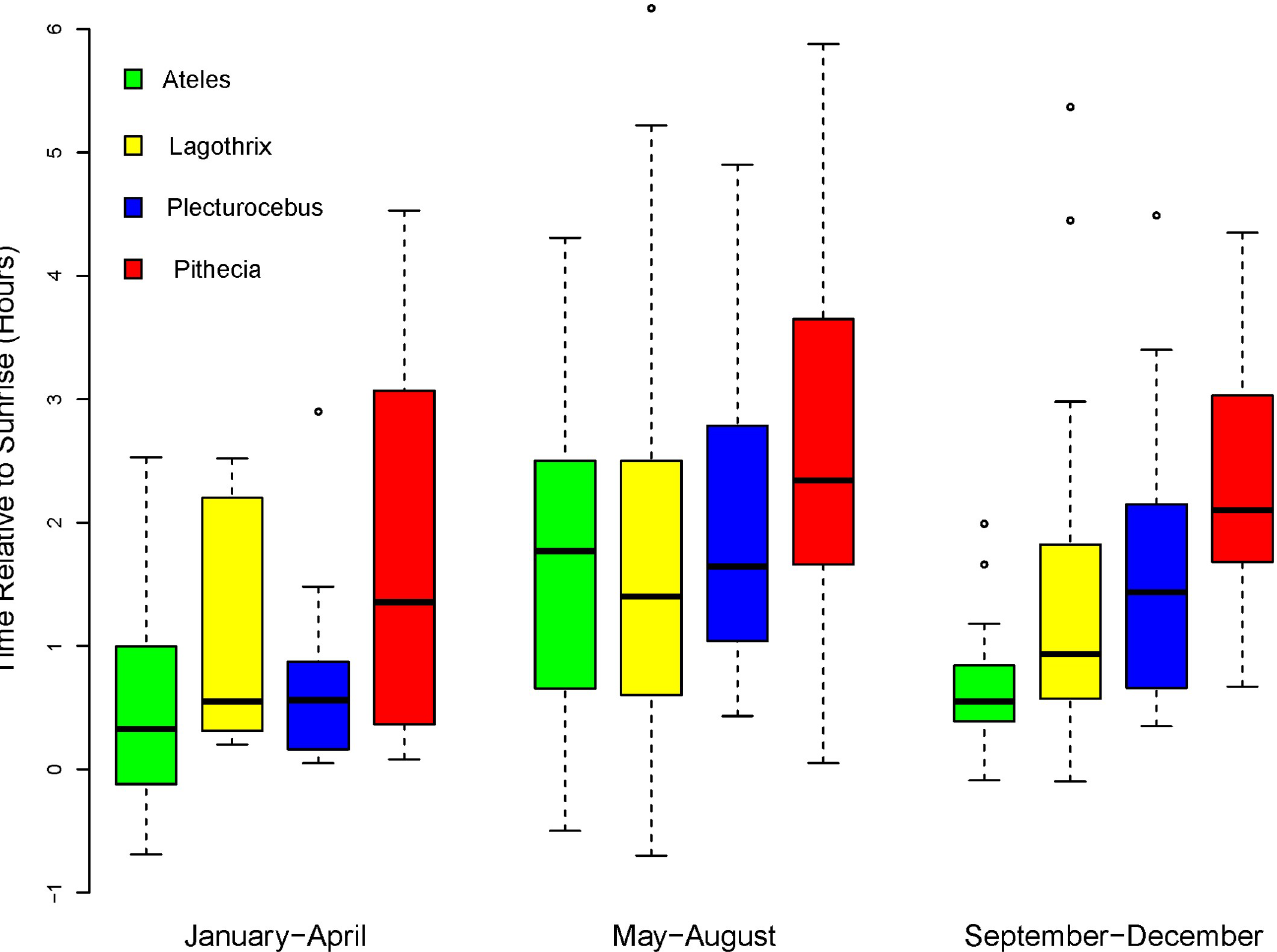
Fig 7. Times of first feeding bouts of all taxa relative to sunrise, grouped by quadrimester. Median values for times of first feeding bouts and numbers of observations are in Table 7.